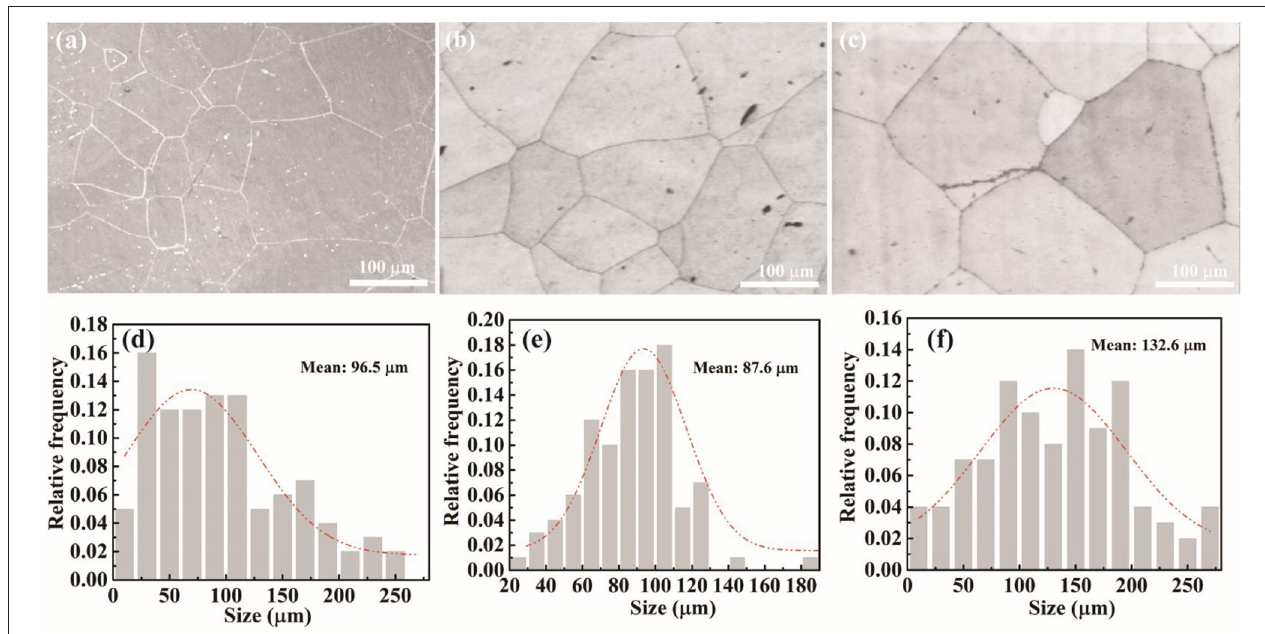
FIGURE 2 | SEM images and corresponding grain size distributions. (a) SEM image of NbTiVZr, (b) SEM image of Nb0.5TiVZr, and (c) SEM image of NbTiV alloys, and (d) the grain size distribution of NbTiVZr alloy, (e) the grain size distribution of Nb0.5TiVZr alloy, and (f) the grain size distribution of NbTiV